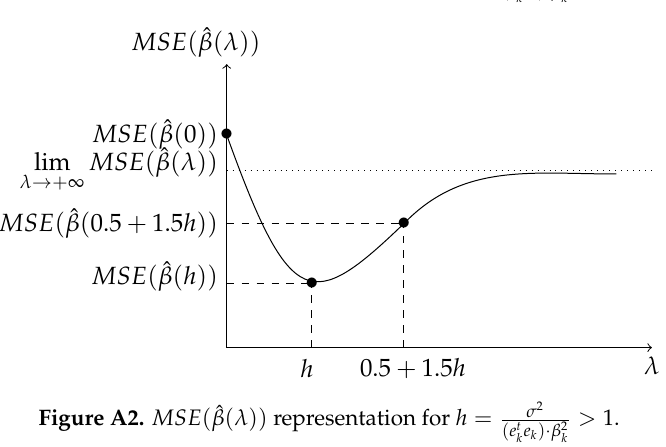
Figure A2. MSE ( ˆ β ( λ )) representation for h = σ 2